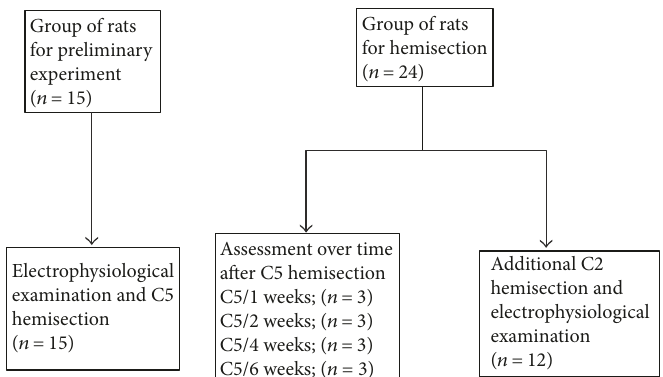
Figure 3: Experimental protocol. Group of rats for preliminary experiment: 15. Group of rats for hemisection: 24 (group assessed over time after C5 hemisection: 12; group that received additional C2 hemisection: 12).